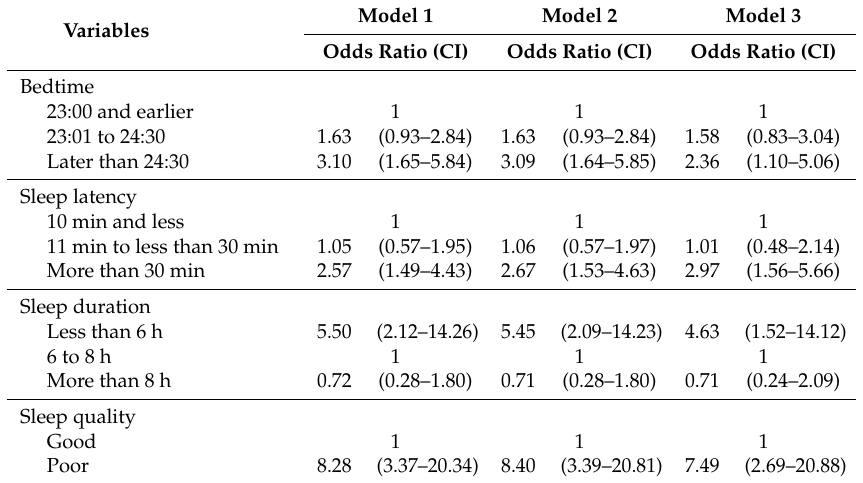
Table 4. Multiple logistic regression of sleep behavior related to depressive symptoms in